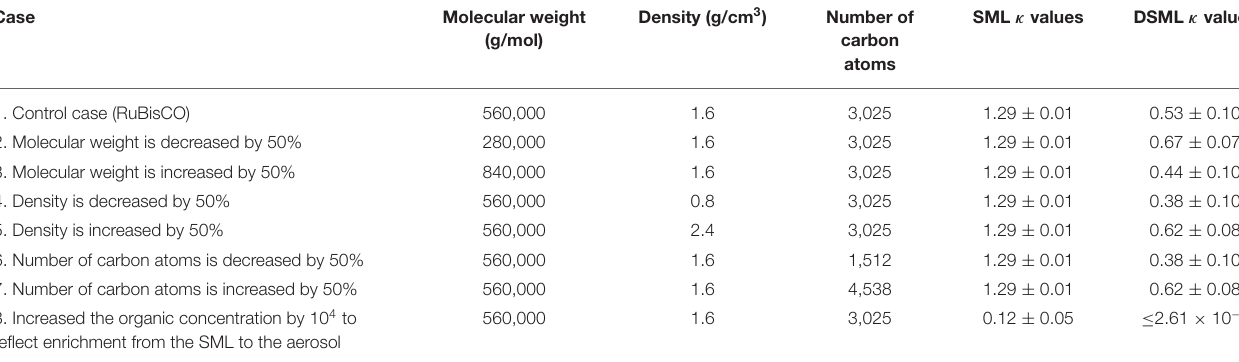
TABLE 5 | Organic properties and their influence on predicted κ values.